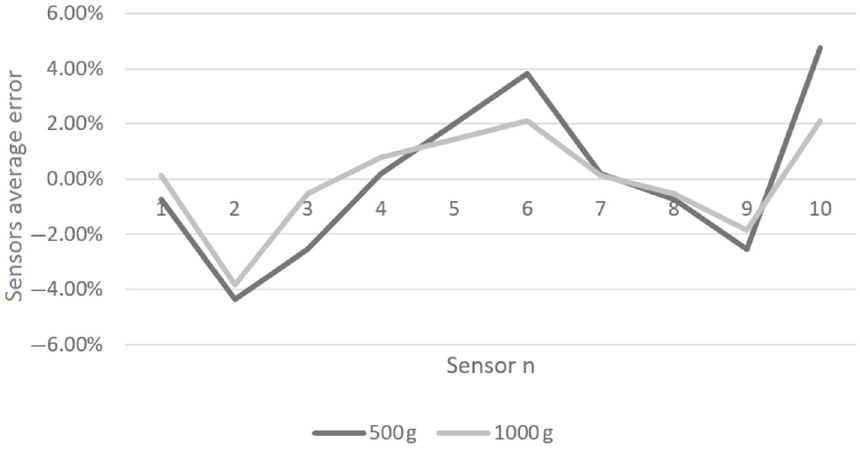
Figure 7. Sensor average error,